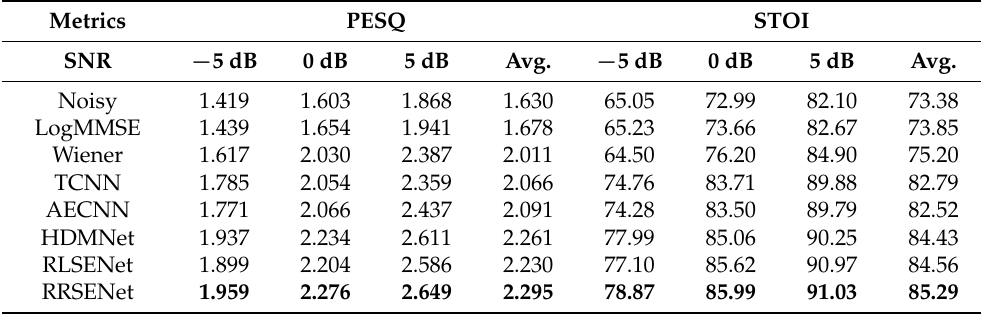
Table 2. Experimental results of different network models under unseen noise conditions for PESQ and STOI. BOLD indicates the best result for each